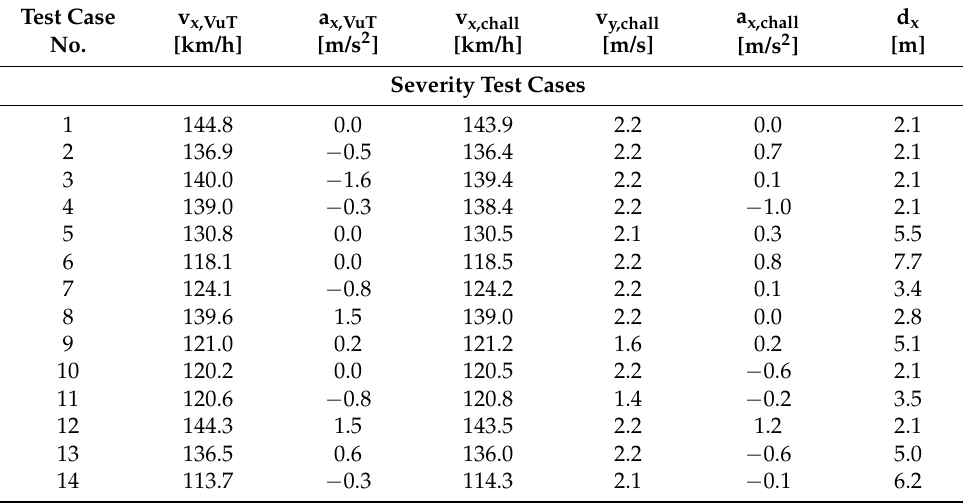
Table 5. Generated severity and exposure test